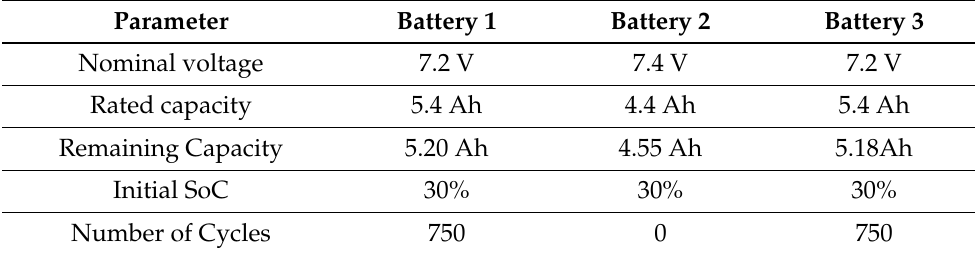
Table 14. Batteries parameters for Case